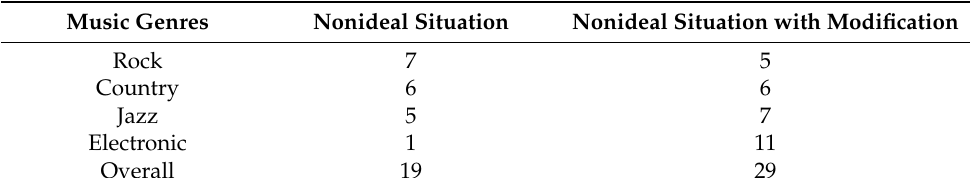
Table 3. Subjective listening scores of different music genres. Music Genres Nonideal Situation